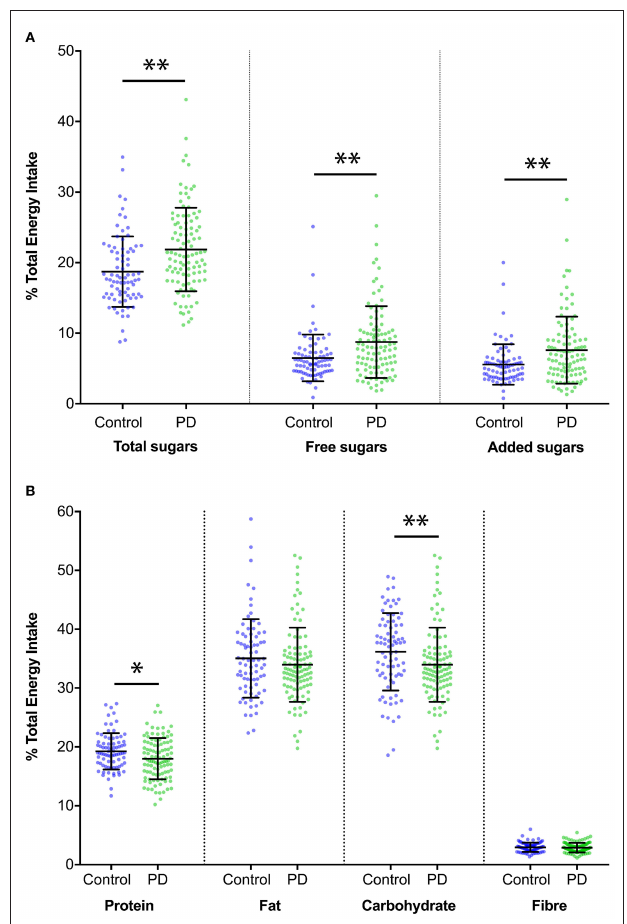
FIGURE 1 | Comparison of macronutrient intake as a percentage of total energy intake. (A) Comparison of sugar intake expressed as a percentage of total energy intake between Parkinson’s disease and healthy control groups (Mean ± [SD]). Patients with Parkinson’s disease consumed a greater amount of total sugars (percentage of total energy intake; 21.9% [5.9] in Parkinson’s disease patients vs. 18.7% [5.0] in healthy controls, p < 0.001). Similar findings were also noted for free sugars (8.8% [5.1] vs. 6.5% [3.3], p = 0.001) and added sugars (7.6% [4.7] vs. 5.6% [2.9], p = 0.001). Statistically significant comparisons of p ≤ 0.001 are indicated with**. (B) Comparison of protein, fat, carbohydrate and fibre intake for Parkinson’s disease and Healthy control groups, expressed as a percentage of total energy intake (Mean ± [SD]). Statistically significant comparisons of p ≤ 0.05 are indicated